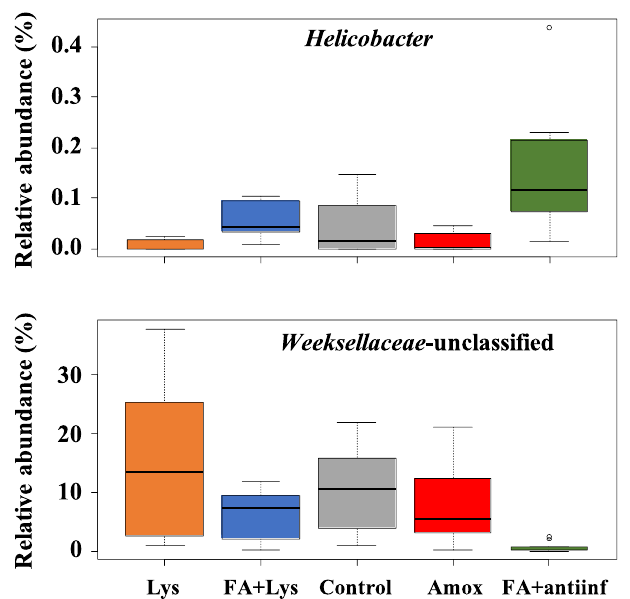
Figure 7. Analysis of composition of microbiomes (ANCOM) on fecal microbiota at genus level comparing groups after treatment (D21). Helicobacter genus and unclassified member from Weeksellaceae family were dected with this differential abundance test. The mean relative abundance of these genera is shown in percentage. Each boxplot corresponds to one treatment group: Lys lysozyme, FA + lys medium chain fatty acids and lysozyme, C control, with no additives, Amox amoxicillin, FA + antiinf medium chain fatty acids and a natural anti-inflammatory. The dotted lines represent standard deviation and outliers are indicated with white